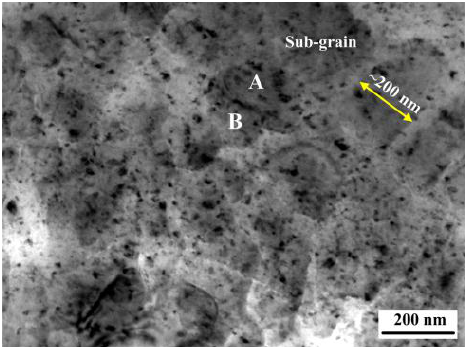
Figure 6. TEM image of the 80-μm deformed layer from the top surface.